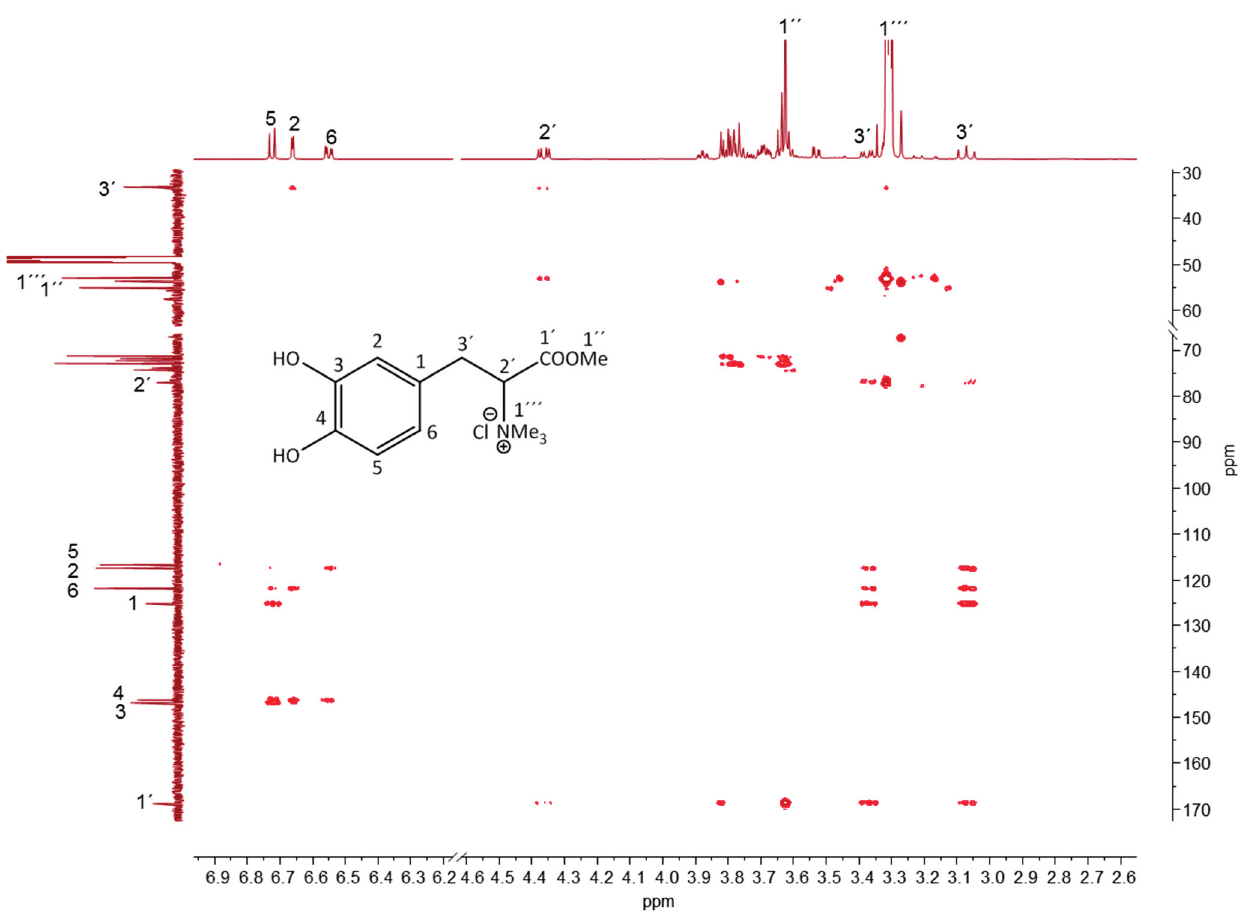
Figure 6. Two-dimensional NMR analysis of crude lichen extracts. Section of the HMBC spectrum of the methanolic extract from #E414 ( Sticta cf. weigelii ). The structure of sticticin is shown in the inset. 13 C- and 1 H-NMR spectra of the crude extract of #E414 are shown as projections with assignments of the sticticin